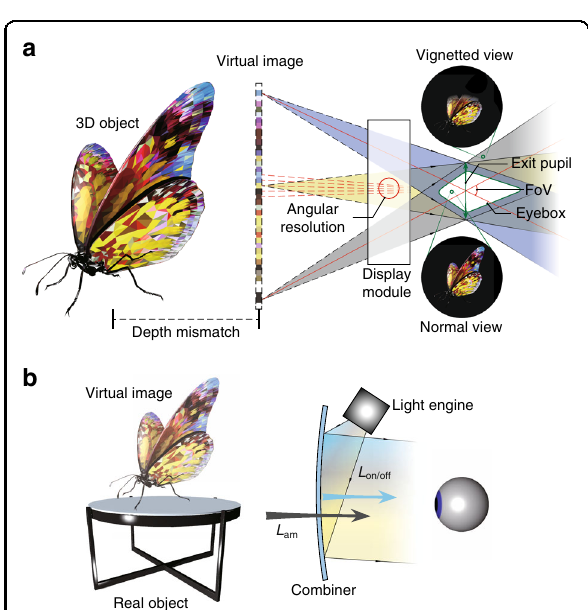
Fig. 2 Illustration of display parameters. a Schematic of a VR display de fi ning FoV, exit pupil, eyebox, angular resolution, and accommodation cue mismatch. b Sketch of an AR display illustrating